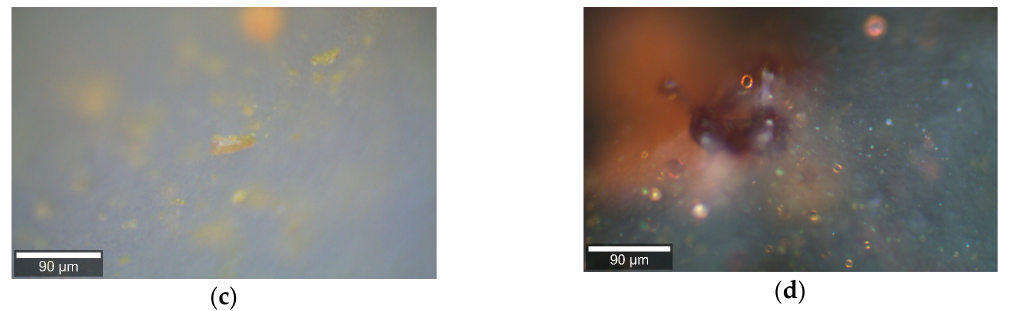
Figure 5. Typical Raman spectra and micrographs of cream (( a ) and ( c ), respectively) and gel (( b ) and